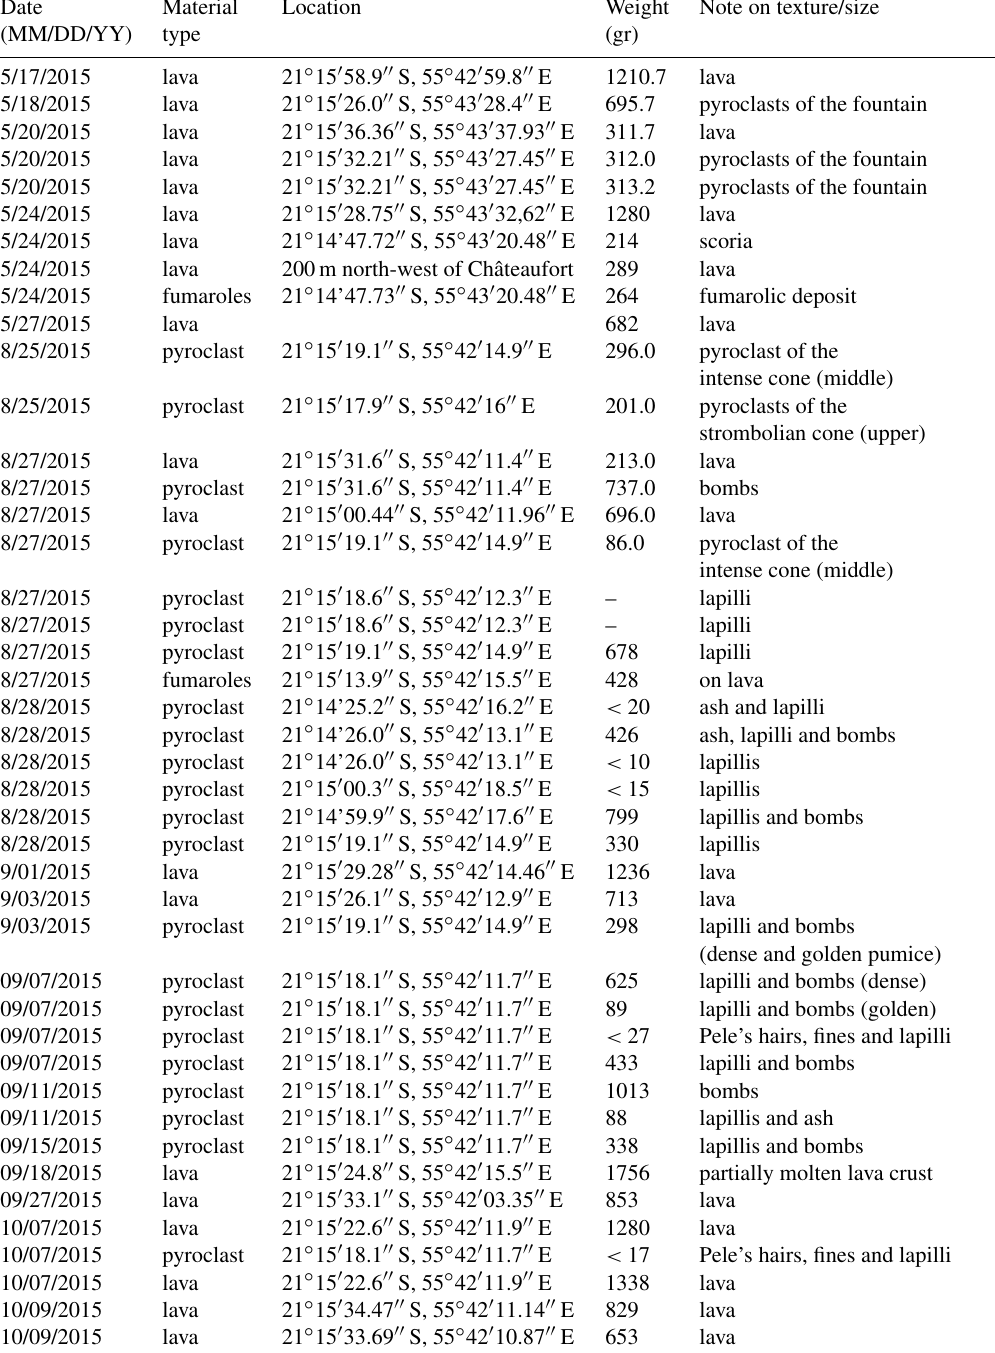
Table A1. Summary of material collected on field near the vent on May–October 2015. Contact the OVPF/IPGP for further details about the